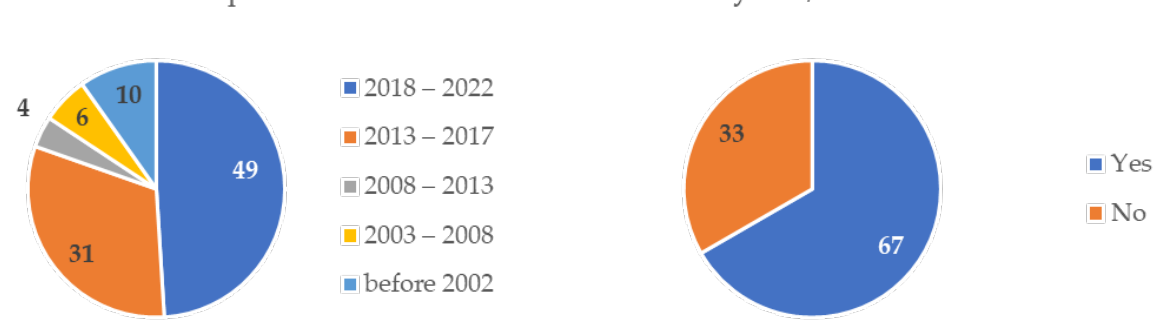
Figure 18. ( a ) The frequency of publication over the years; ( b ) The frequency of model description. The values are expressed in percentages.